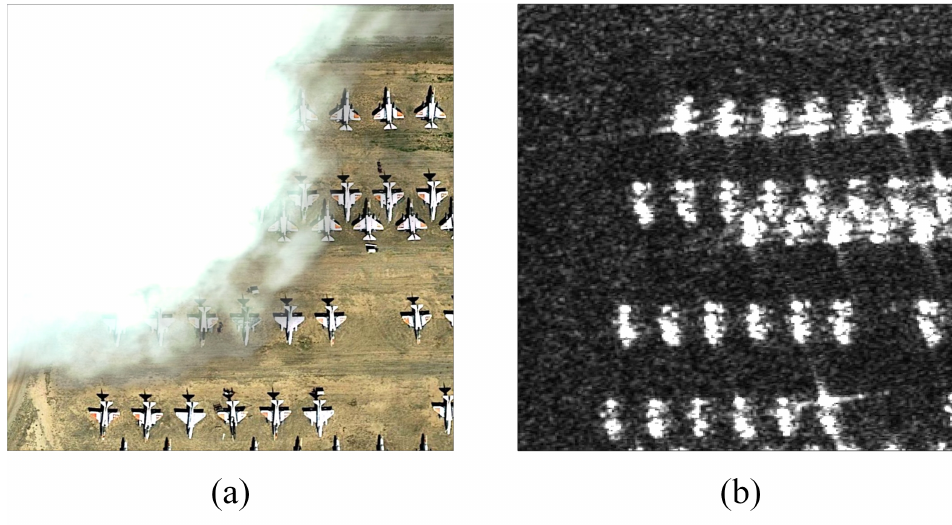
Figure 1. Optical and SAR images. ( a ) Optical image. ( b ) SAR